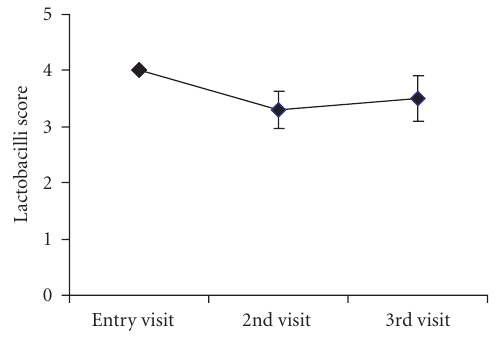
Figure 2: Lactobacilli score from the Nugent slide at entry, 2nd and 4th visit showed no significant ( P > . 05) decrease from baseline during 2nd and 3rd visit. Data expressed as mean n =